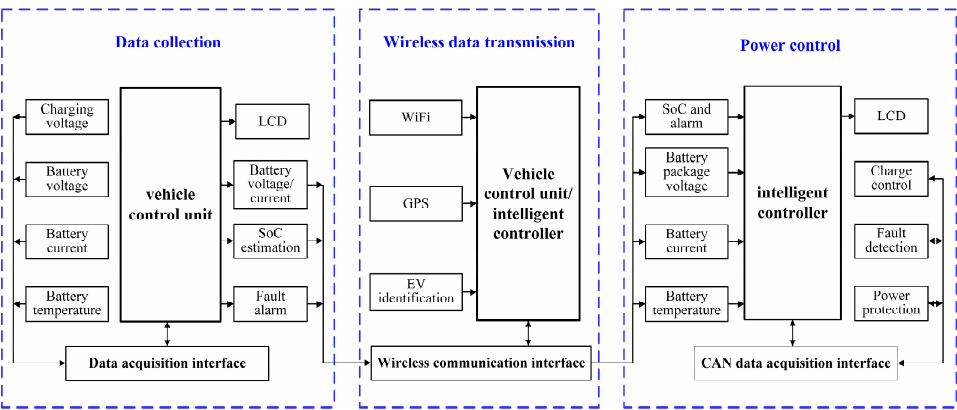
Figure 3. Schematic diagram of the wireless communication unit. LCD: liquid crystal display; SoC: state of charge; EV: electric vehicle; CAN: controller area network.